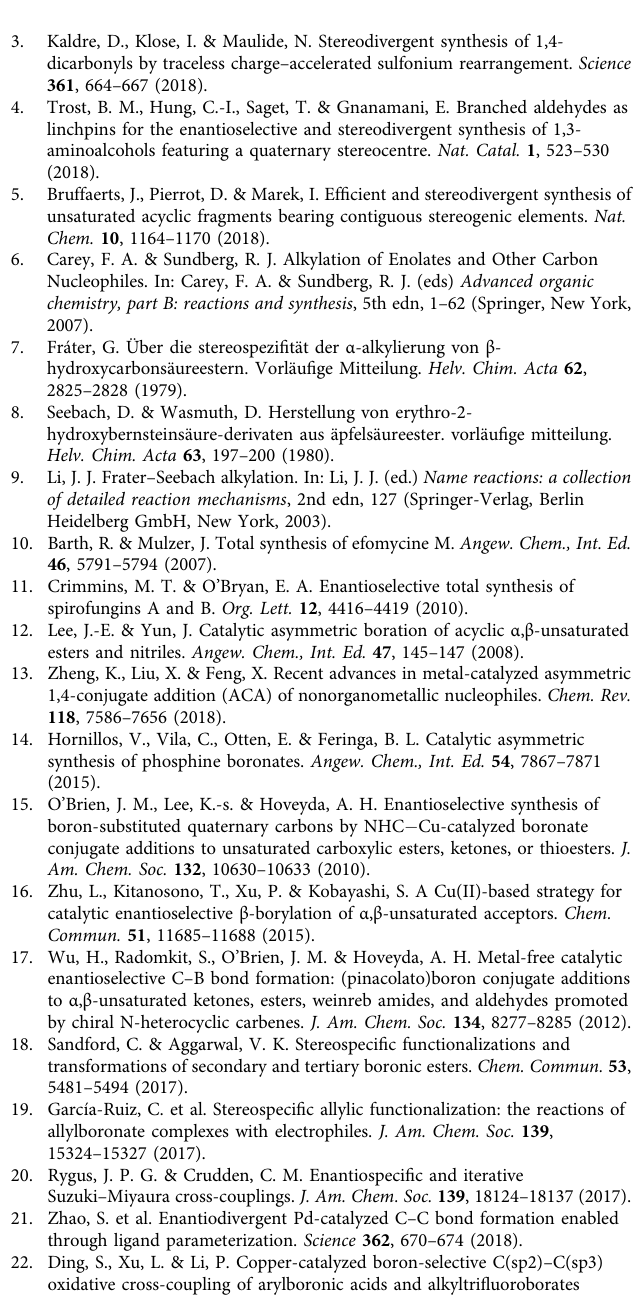
Fig. 7 Synthetic utility of the divergent methodology. Uni fi ed enantioselective synthesis of cis and trans diols 19 and